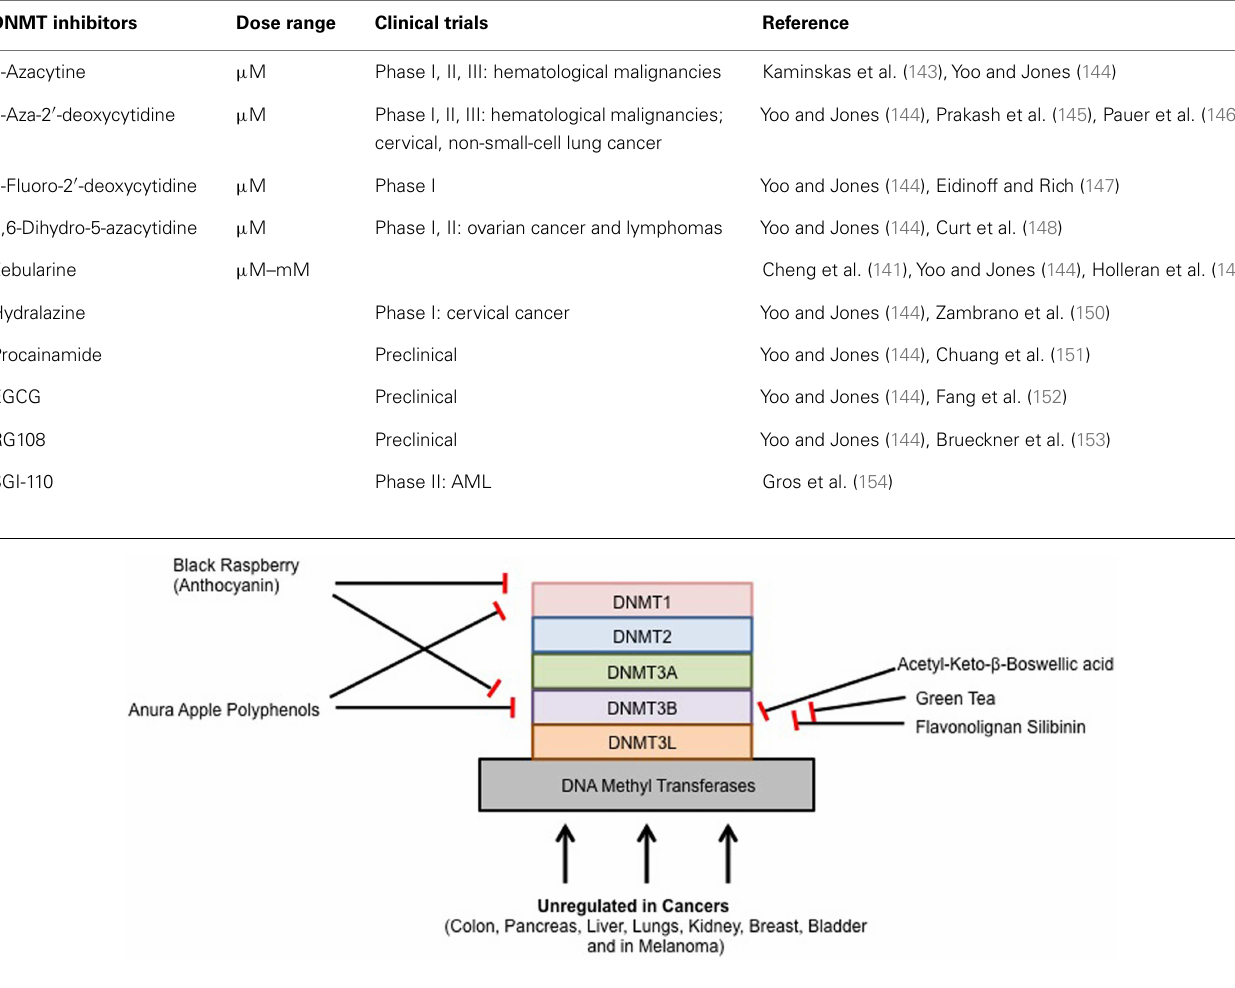
Table 2 |Available DNMT in inhibitors and cancer .